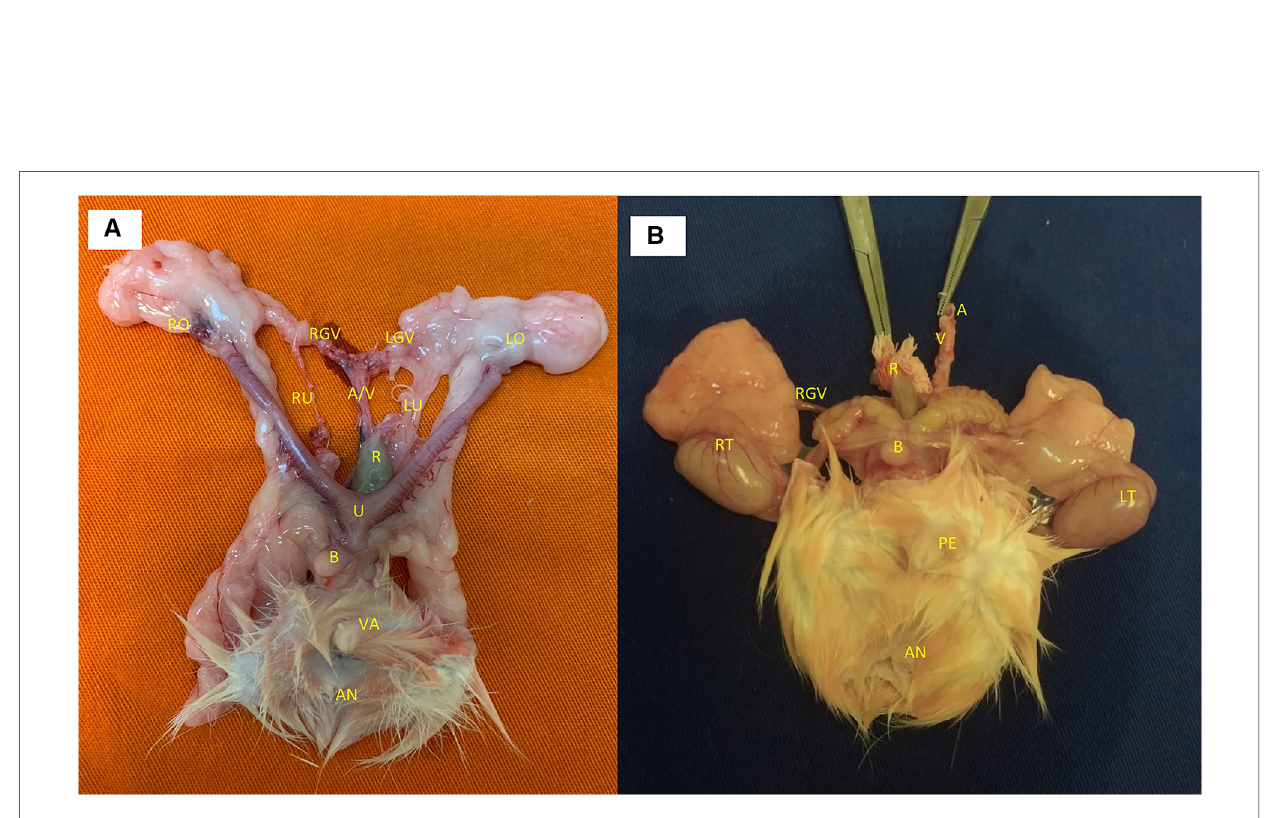
FIGURE 3 ( A ) female graft: RO, right ovary; LO, left ovary; RGV, right gonadal vessels; LGV, left gonadal vessels; A/V, aorta and vena Cava; RU, right ureter; LU, left ureter; R, rectum; U, uterus; B, bladder; VA, vagina; AN, anus. ( B ) Male graft: RT, right testicle; LT, left testicle; RGV, right gonadal vessels; R, rectum; A, aorta; V, vena cava; B,bladder; PE,penis;